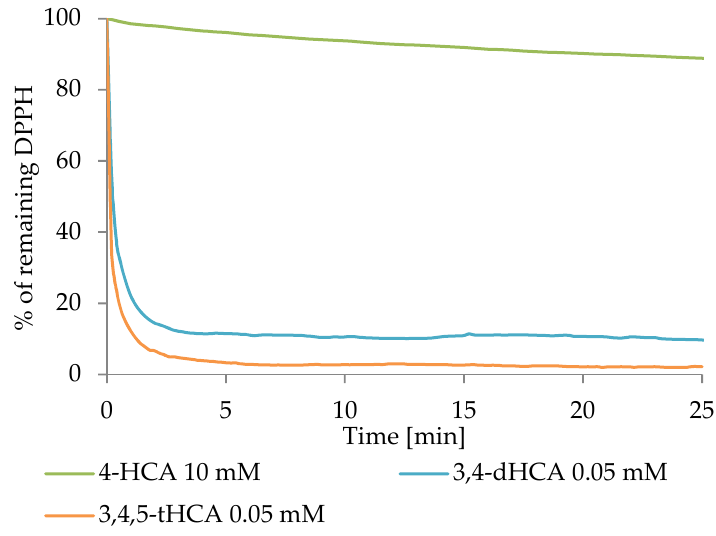
Figure 6. The DPPH  radical scavenging kinetics of chosen compounds. Figure 6. The DPPH • radical scavenging kinetics of chosen